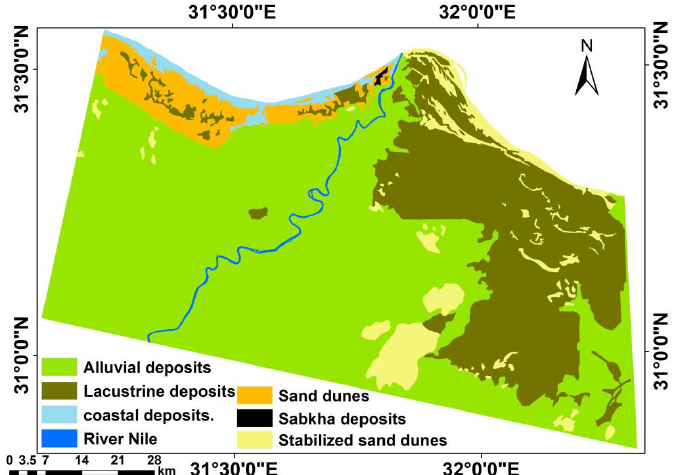
Figure 3. Geomorphology of the area; it was performed using the overlapping of DEM, Landsat-8, and Geology of Conco [42].